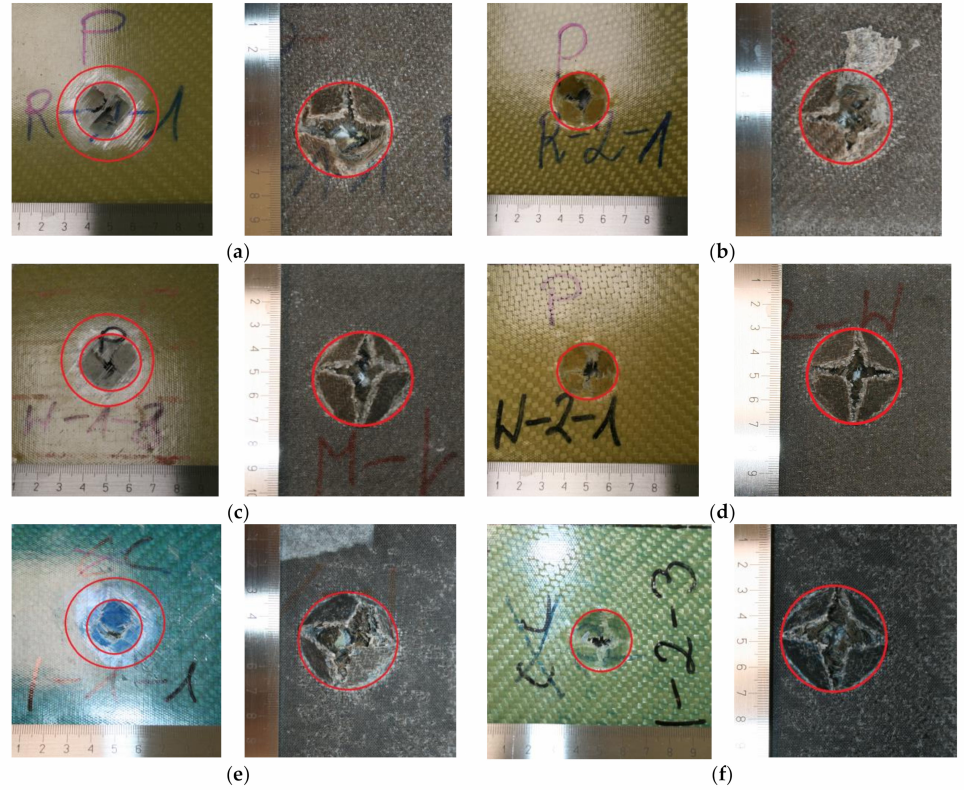
Figure 3. Photographs of internal and external surfaces of hybrid composites H-GACBF ( a ), H- AGCBF ( b ), V-GACBF ( c ), V-AGCBF ( d ), I-GACBF ( e ), I-AGCBF ( f ) after impact